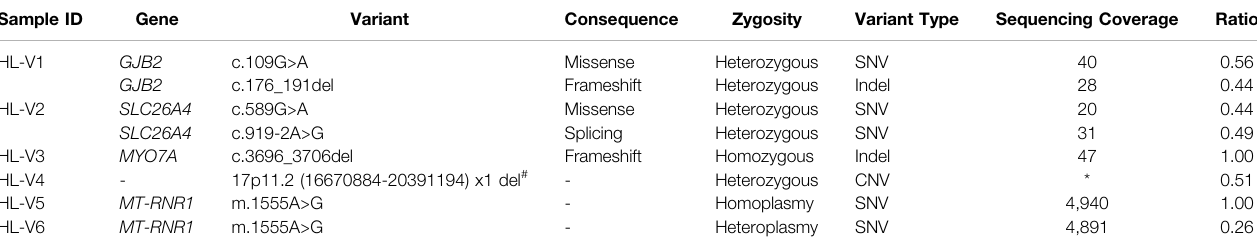
TABLE 1 | The results of whole genome sequencing for six samples with known genetic variation.